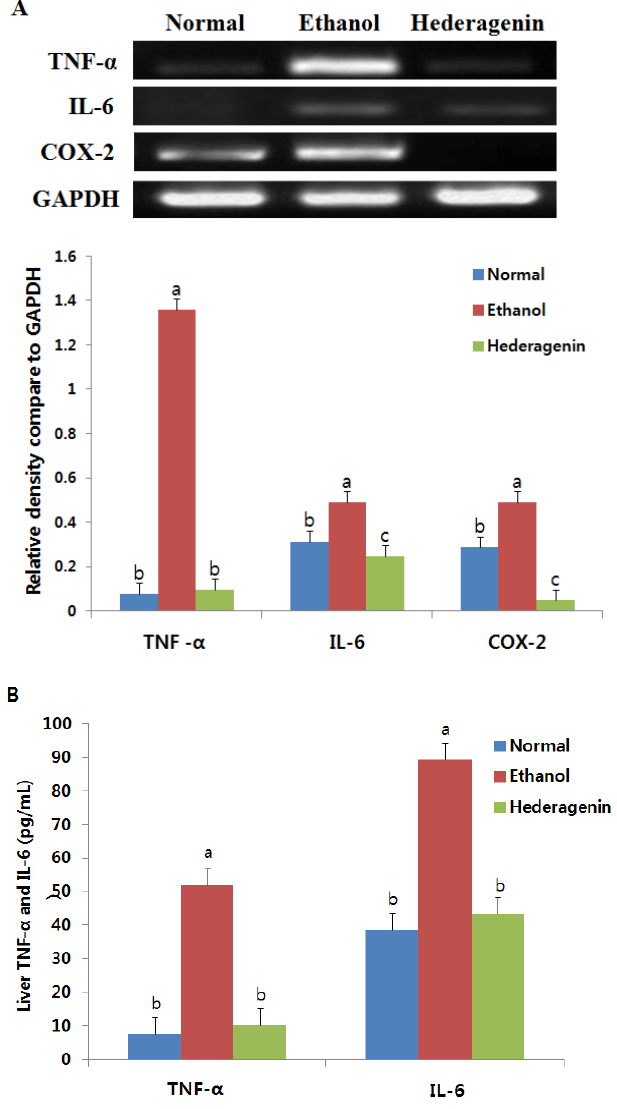
Figure 4. Effect of hederagenin on inflammation-related gene expression in the livers of ethanol-exposed rats ( A ); and mRNA expression of the liver TNF- α , IL-6, and COX-2 assessed using RT-PCR ( B ). The liver concentration of TNF- α and IL-6 was determined using an enzyme-linked immunosorbent assay. Results are expressed as the means ± SD. Significant differences ( p < 0.05) are represented using different letters. TNF, tumor necrosis factor; IL, interleukin; COX, cyclooxygenase.